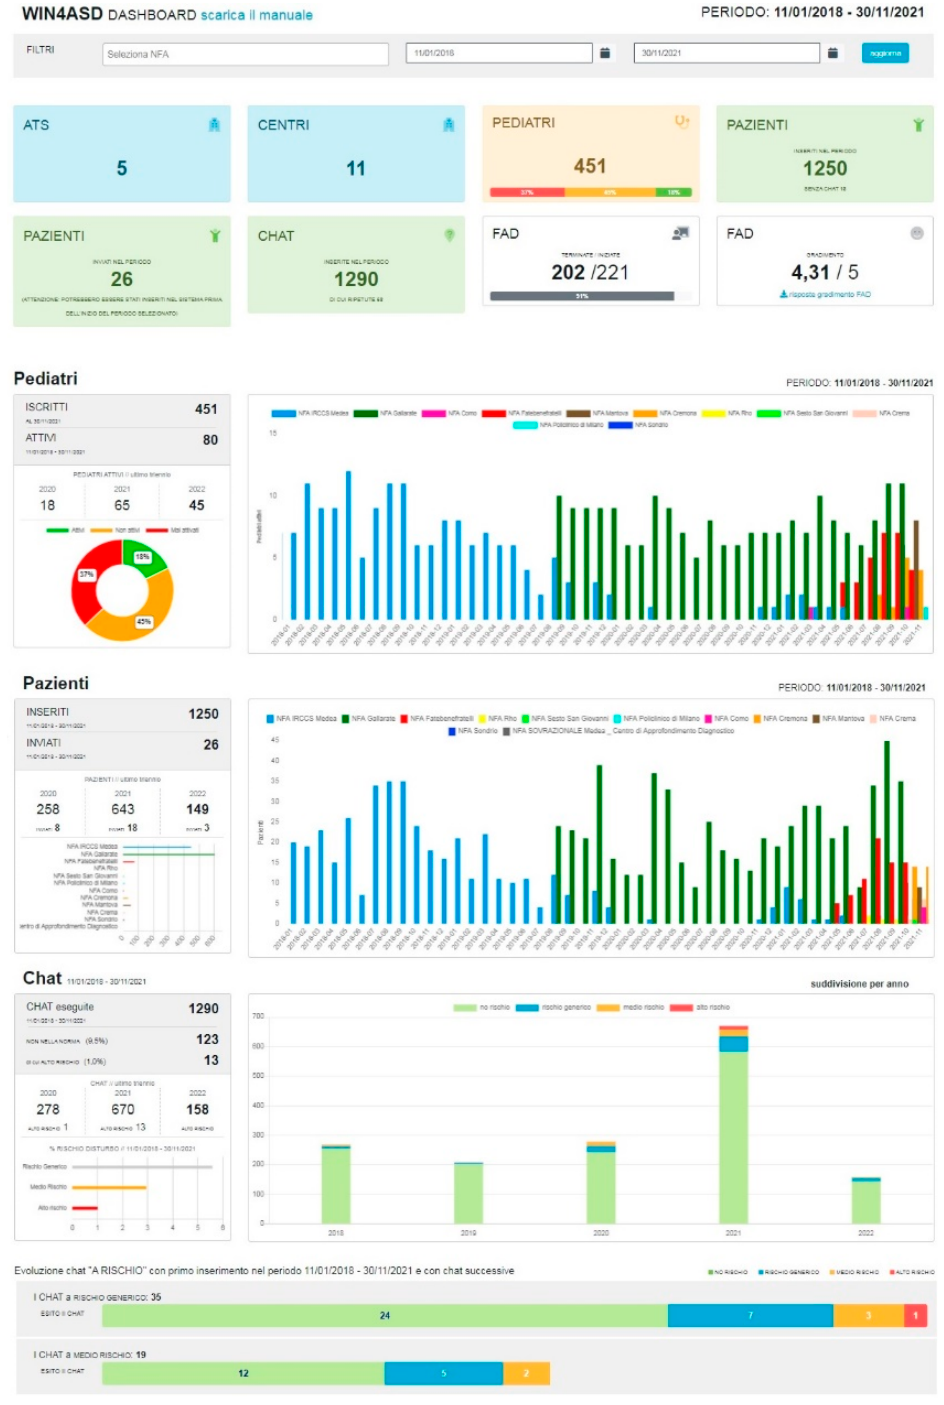
Figure 3. WIN4ASD dashboard.